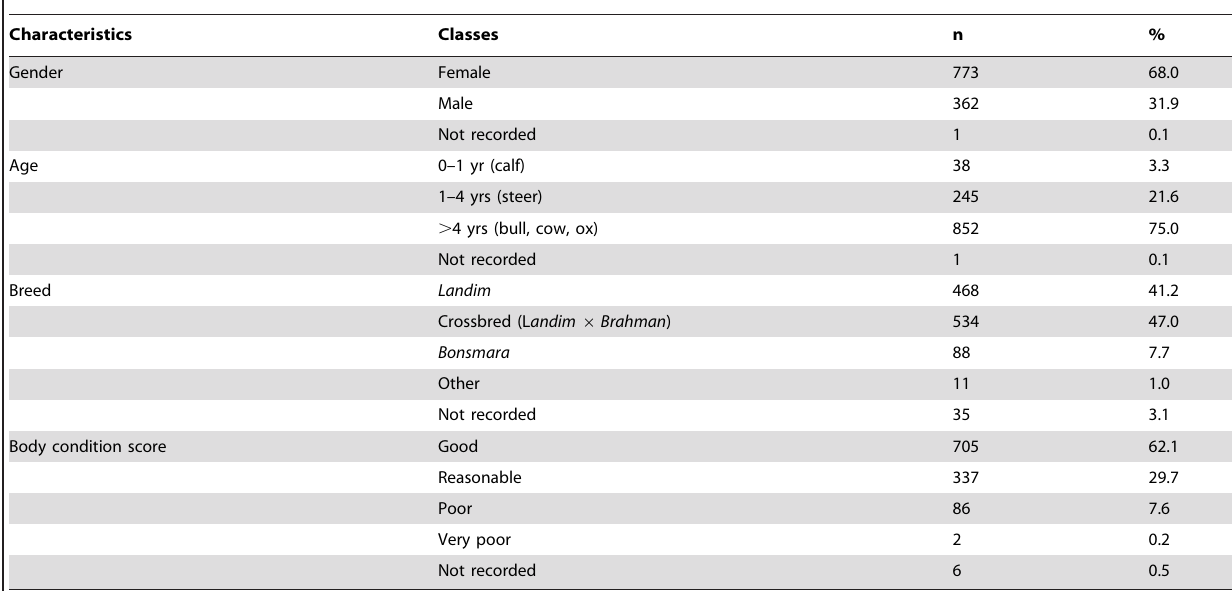
Table 1. Basic characteristics of the sample.